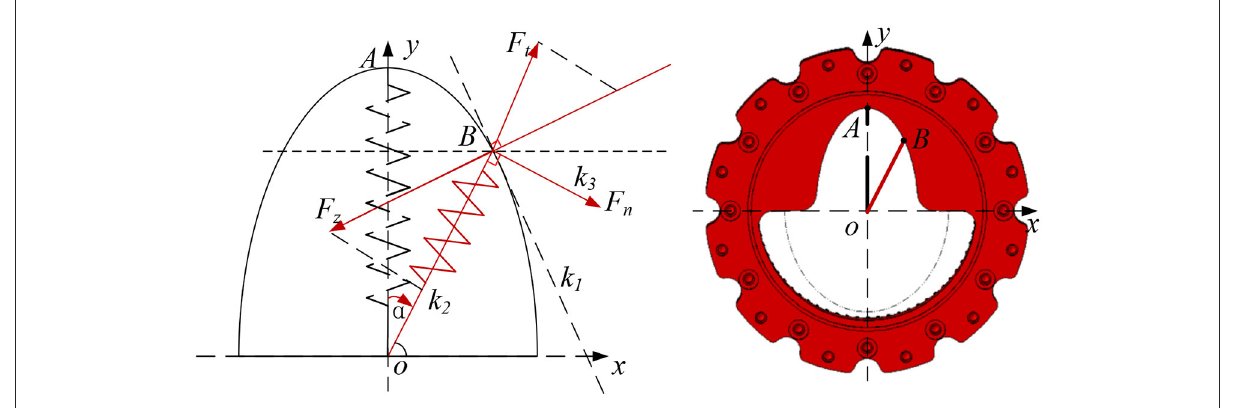
FIGURE4 Theoretical analysis of special surface.